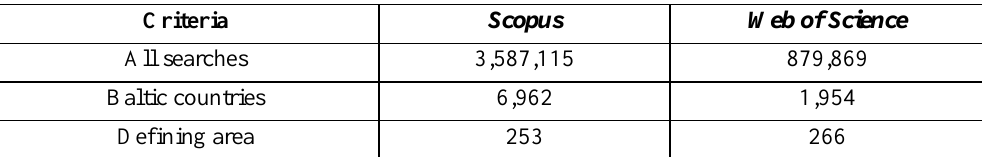
Table 1. Search results in Scopus and Web of Science